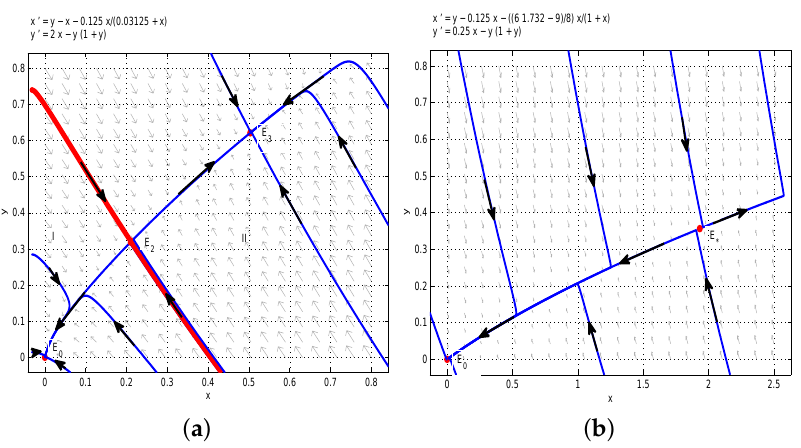
Figure 2. ( a ) ∆ ( b ) < 0. Two coexisting internal equilibria and one boundary equilibrium when b ≥ c ( e − a ) : two stable nodes E 0 and E 3 and a saddle E 2 . ( b ) ∆ ( b ) = 0, ˜ A > 0. E ∗ is the only internal equilibrium, and it is the saddle node.